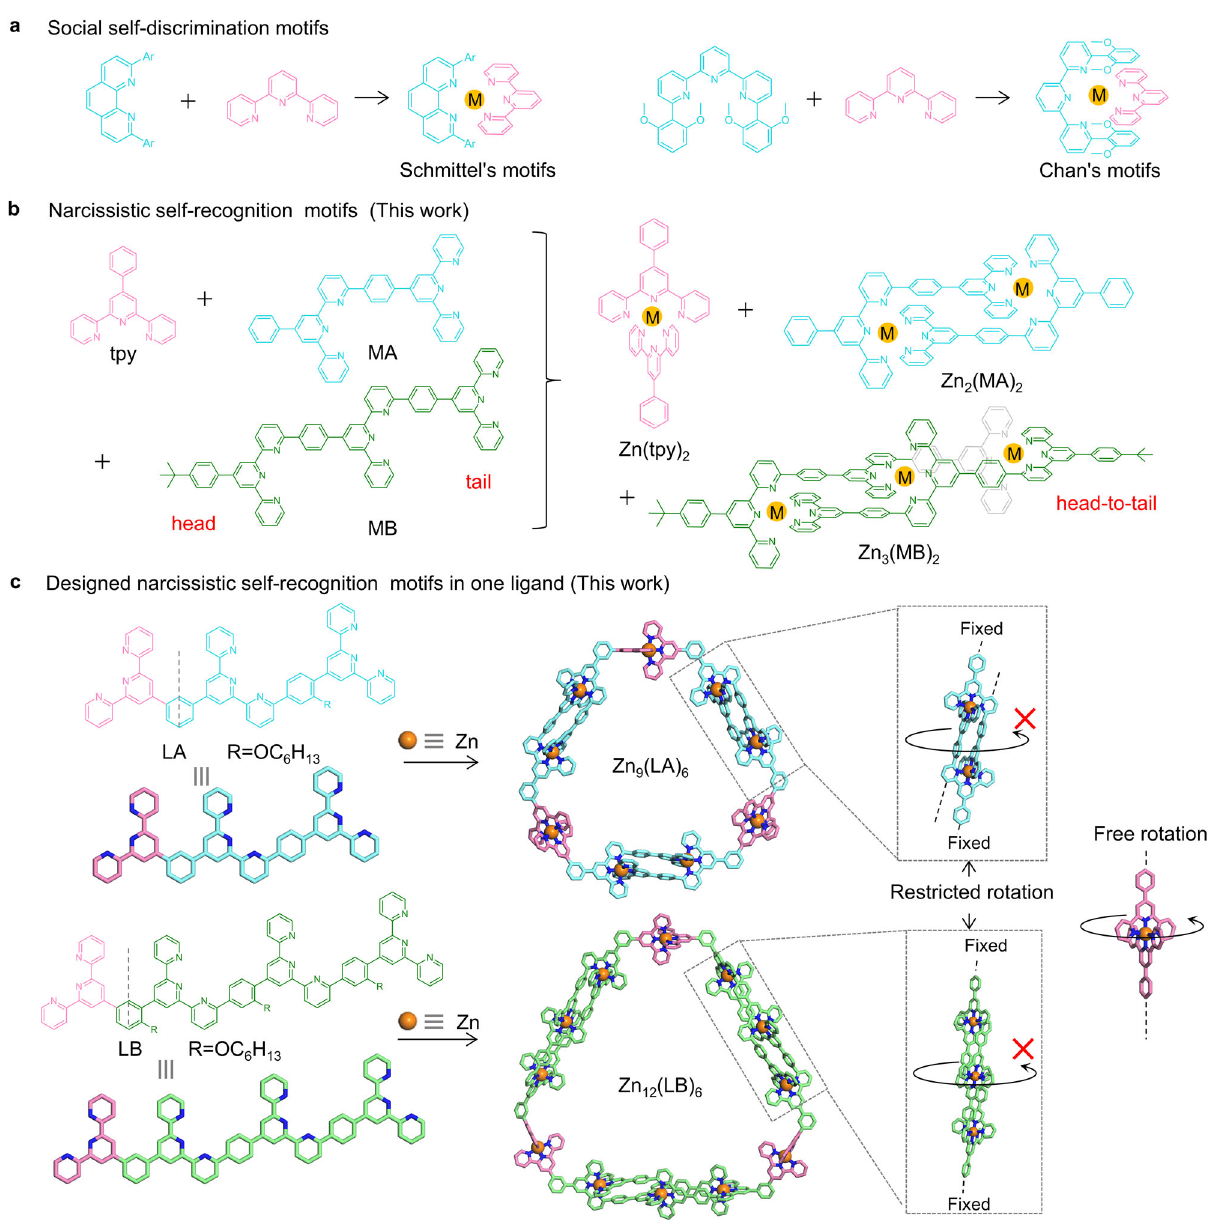
Fig. 1 The self-assembly of metallo-macrocycles by the narcissistic self-recognition tpy moieties. Two different self-sorting processes in coordination- driven self-assembly; a social self-discrimination motifs in literatures; b narcissistic self-recognition motifs in the current work. We combined the narcissistic self-recognition tpy moieties with tpy to form multitopic ligands for precise self-assembly of metallo-macrocycles. c Schematics for the self- assembly of hexagonal macrocycles Zn 9 (LA) 6 and Zn 12 (LB) 6